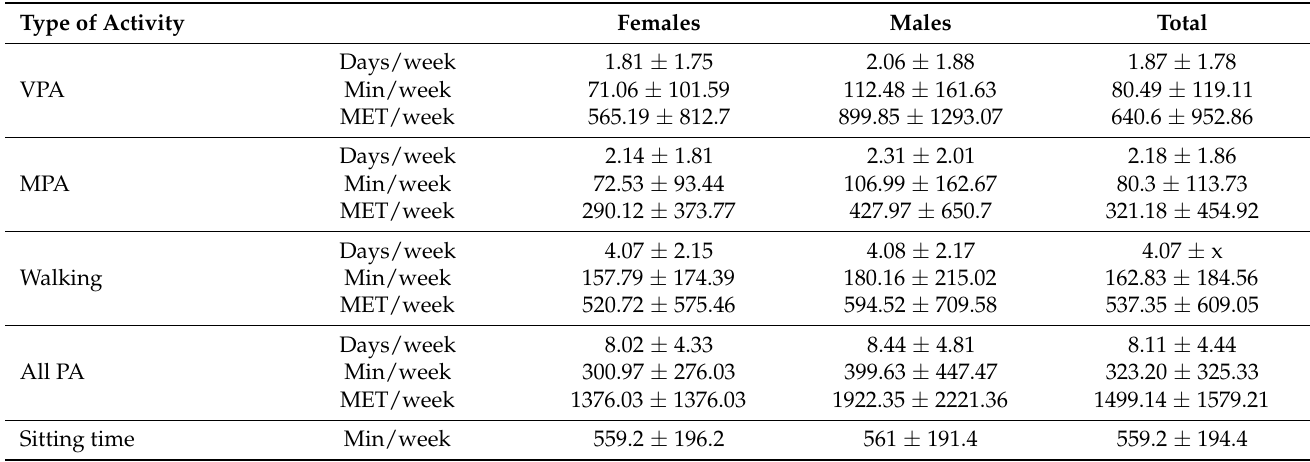
Table 2. IPAQ-SF